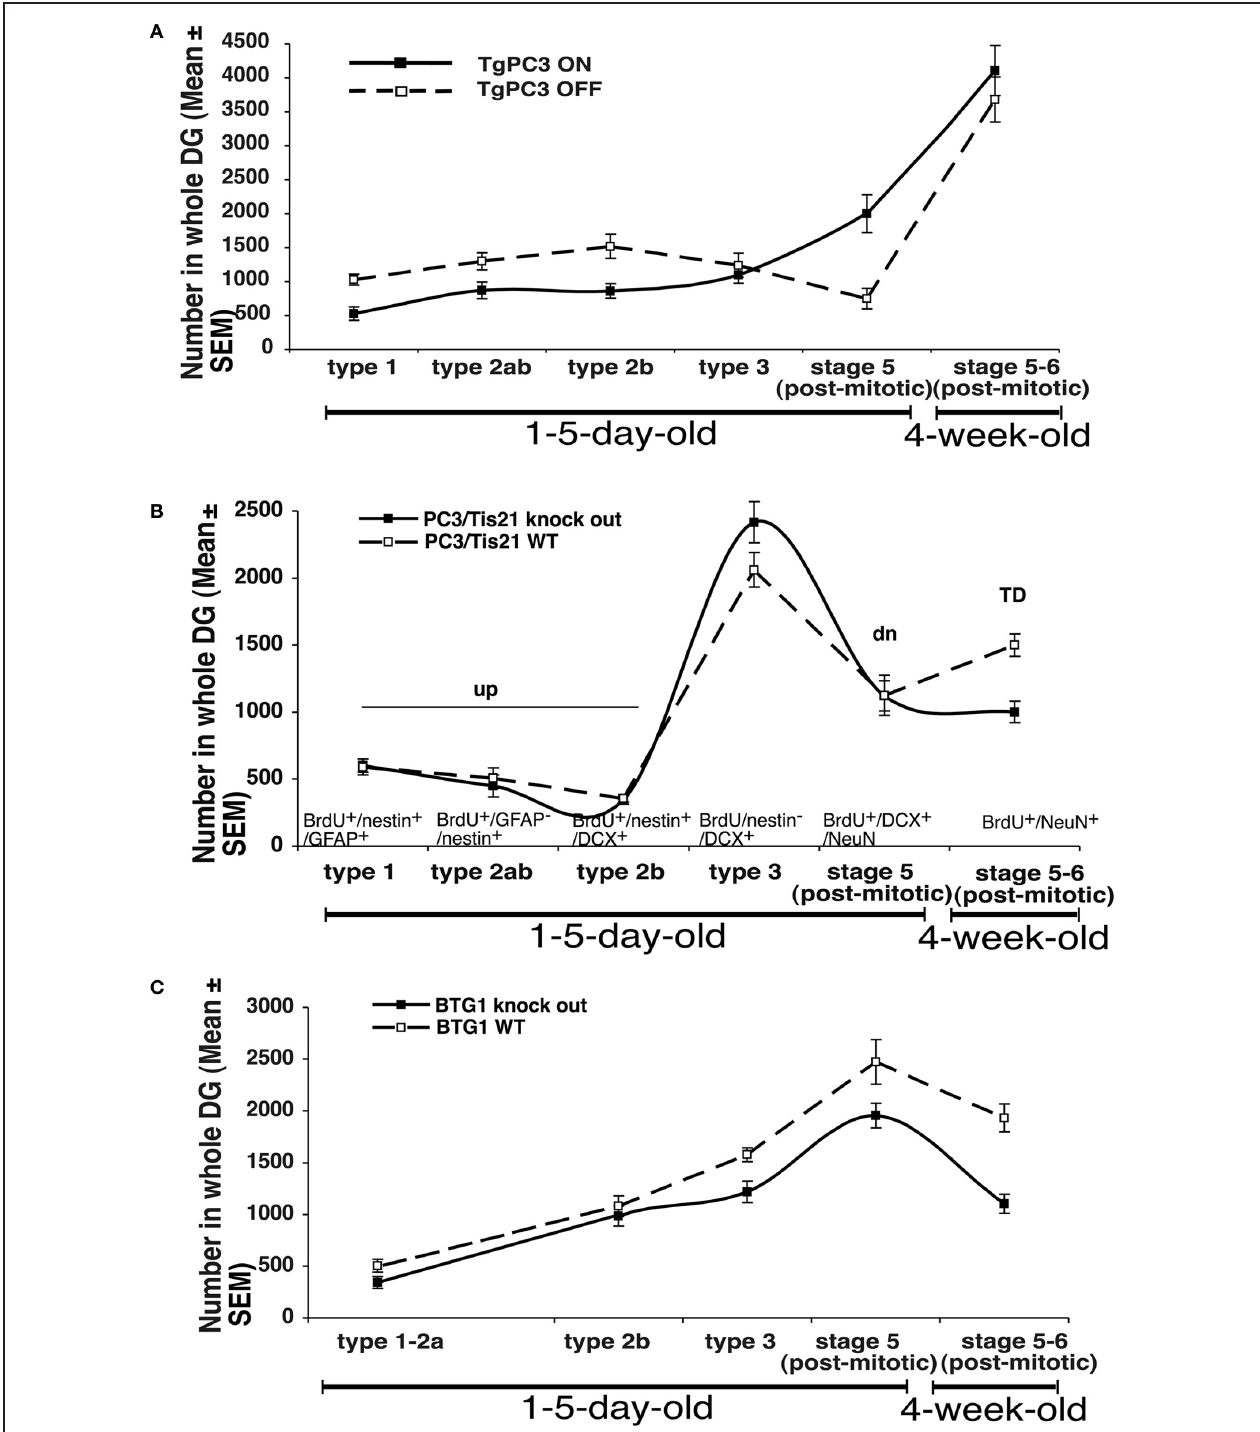
FIGURE 1 | Summary of the relative changes observed in the number of progenitor cell types and neurons of the dentate gyrus in the transgenic mouse model PC3/Tis21 (Tg PC3/Tis21) (A), or in PC3/Tis21 and Btg1 knockout mice (B,C). The markers used to identify the different types of neurons are indicated in panel (B) . The number of progenitor cells and neurons shown in